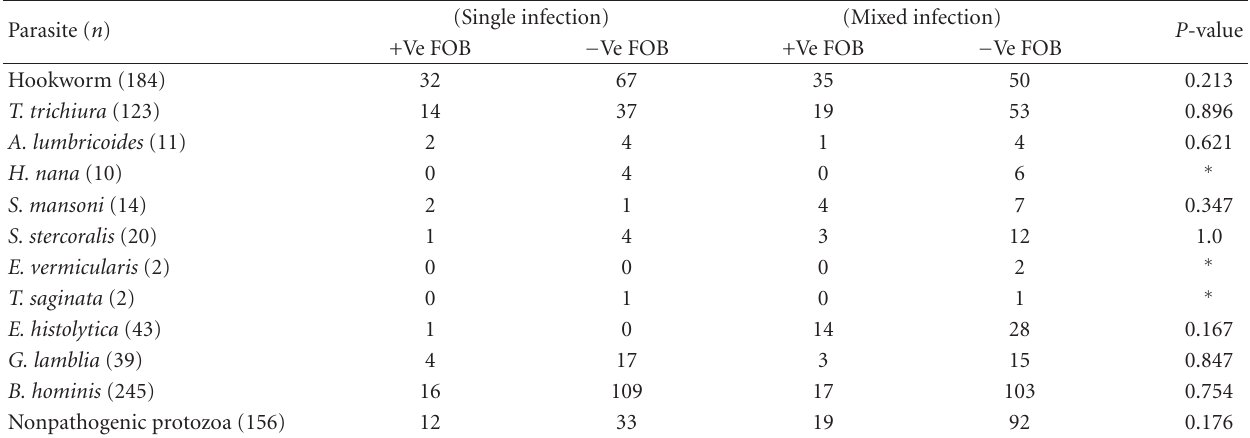
Table 2: FOB results in correlation with infection of detected parasites. n = number of infected cases. ∗ All samples were negative for FOB